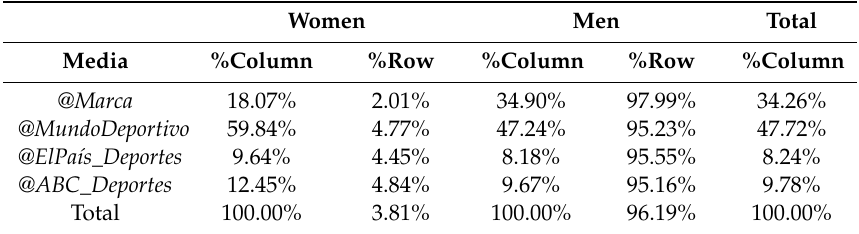
Table 1. Sample distribution of gender according to communication media for tweets (n =